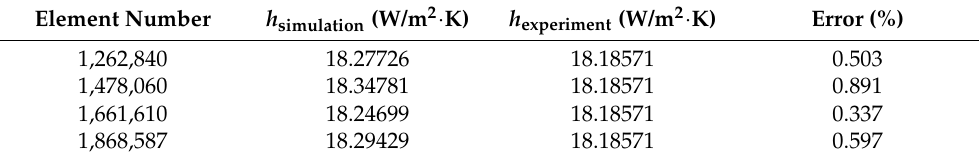
Table 2. Grid independent test.